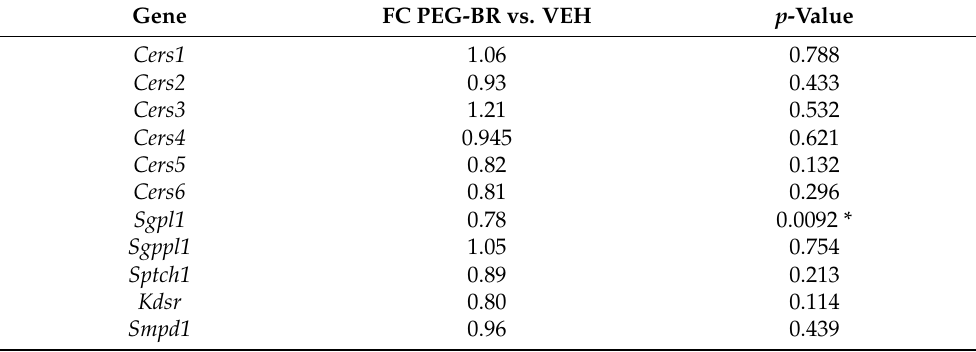
Table 2. Fold Change (FC) of real-time PCR expression of genes in the livers of obese mice treated with PEG-BR or VEH.